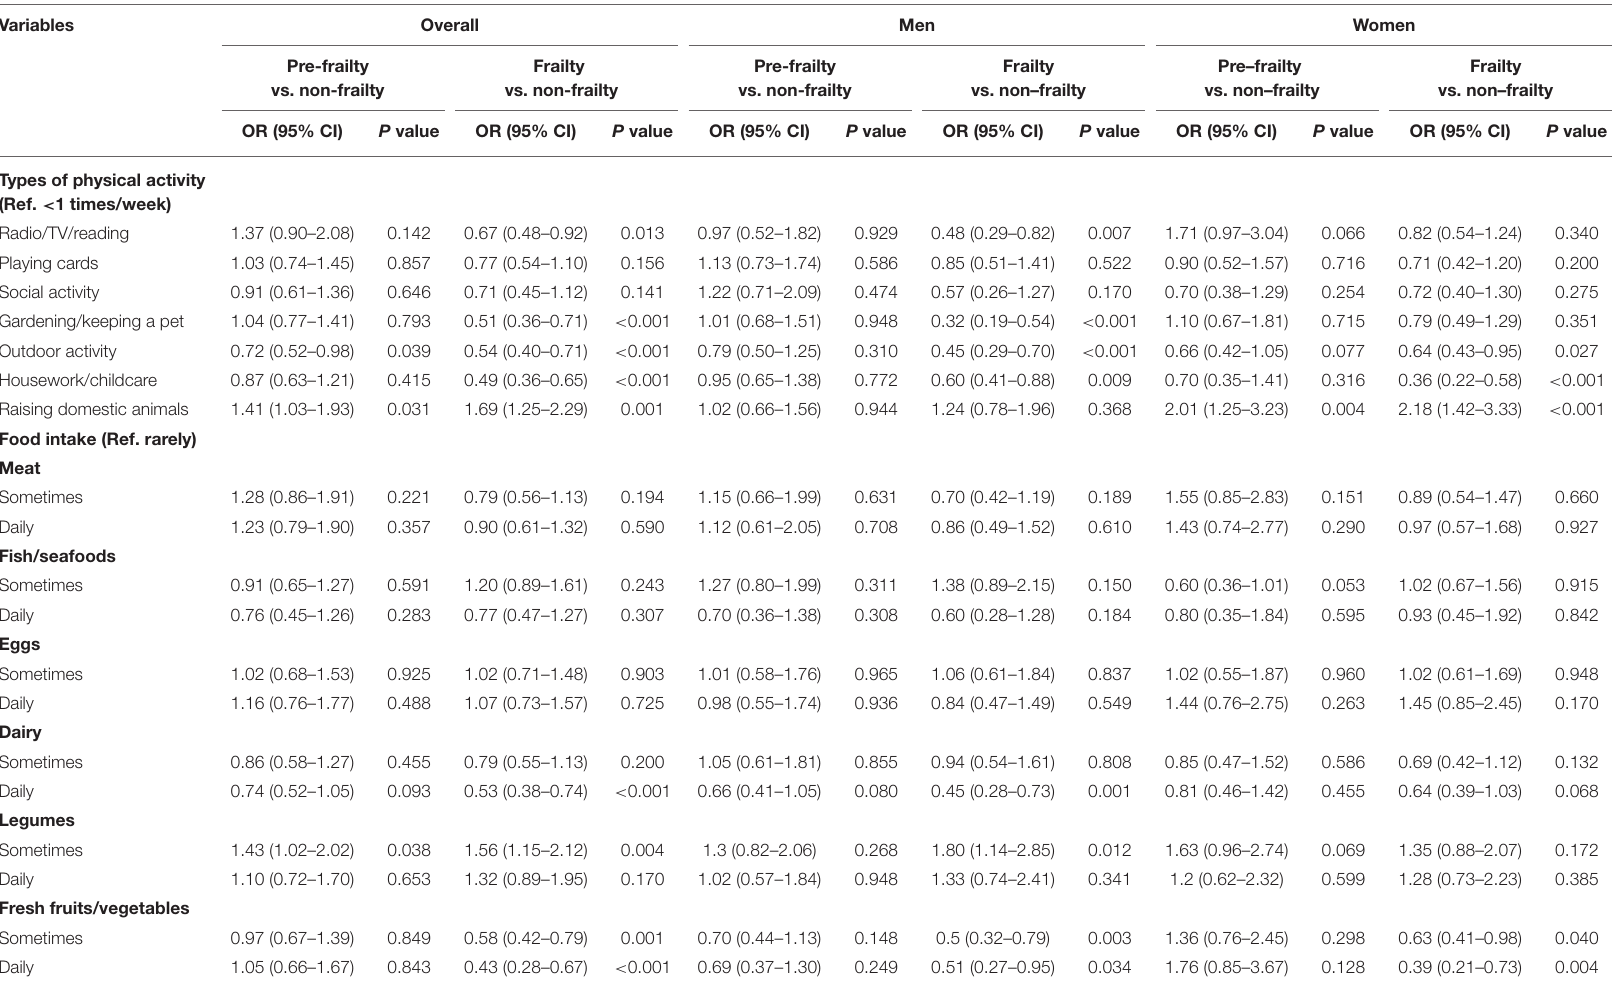
TABLE 4 | Association among the types of physical activity, types of food intake and the risk of pre-frailty, frailty, and sex